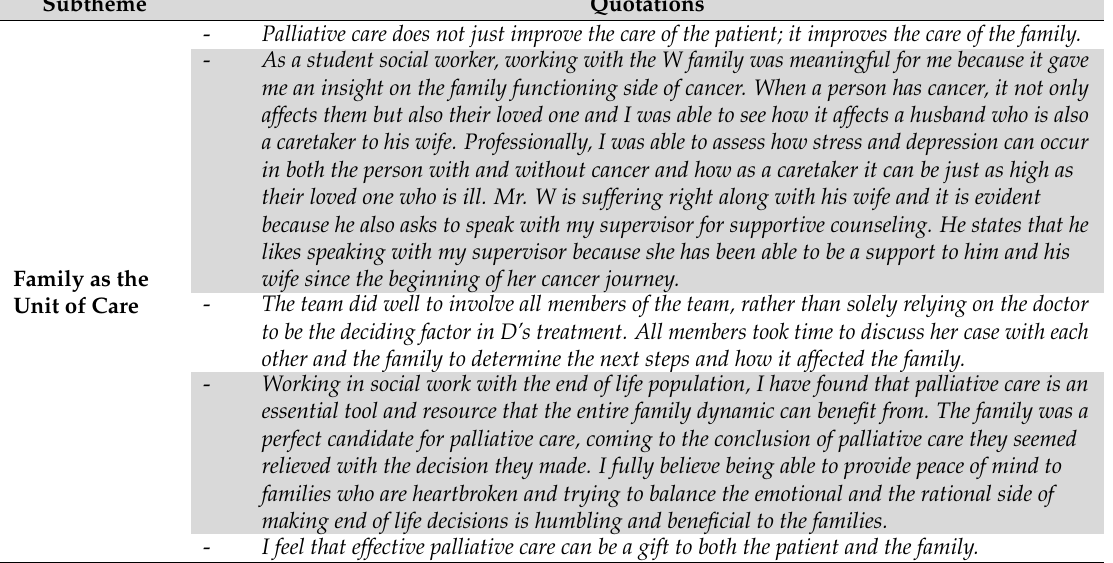
Table 8. Quotes related to the subtheme of appreciation of family as the unit of